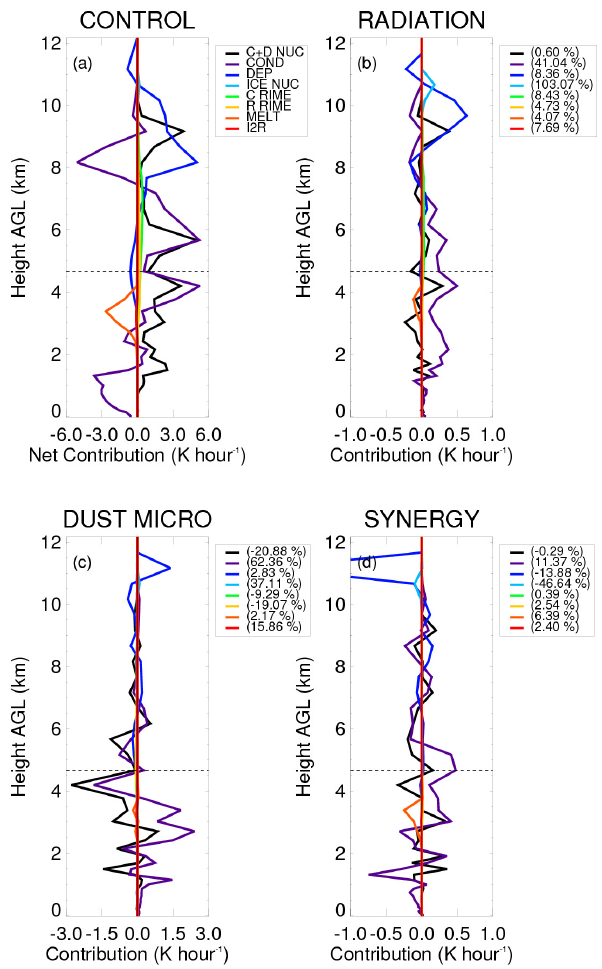
Fig. 14. Cloud-averaged vertical profiles of all microphysical pro- cesses that contribute to latent heating (Kh − 1 ) for (a) CONTROL, (b) RADIATION, (c) DUST MICRO, and (d) SYNERGY. Cloud is defined by any grid cell that contains at least 0.01 g kg − 1 of total